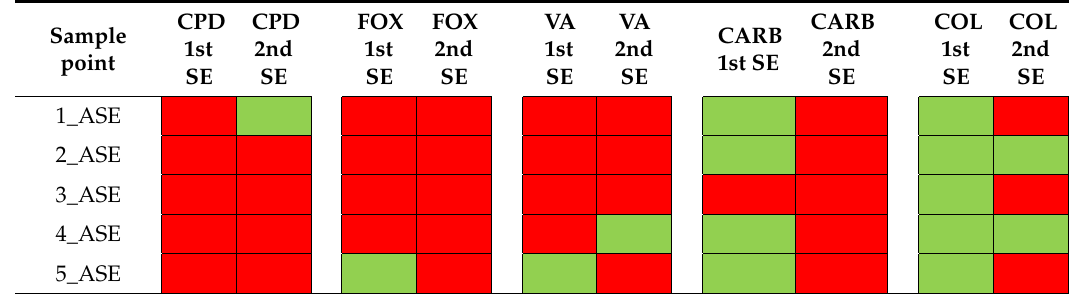
Table 3. Isolation of resistant bacteria in selective culture media (red: presence; green: absence). 1st SE, 2nd SE: first and second sampling events; ASE: Ebro Basin; ASC: Cantabrian